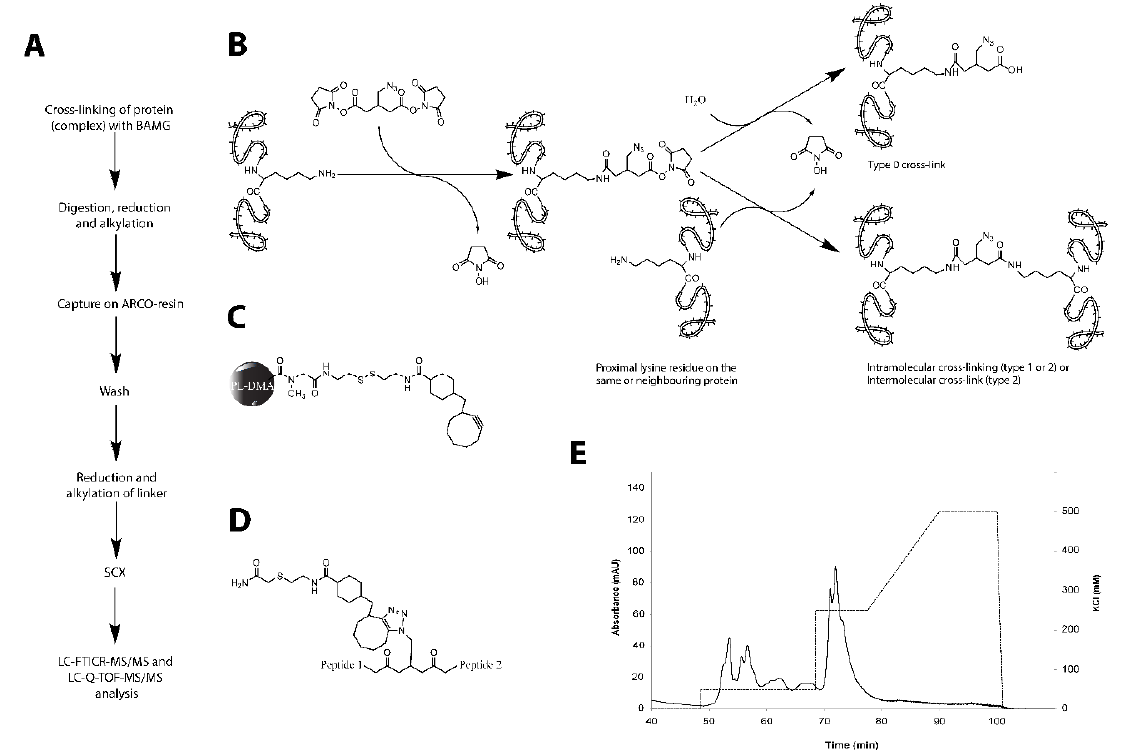
Figure 1. Overview of the used cross-linking methodology and terminology. ( A ) experimental work flow. Proteins are incubated with the azide-containing cross-linker bis (succinimidyl)-3-azidomethyl glutarate (BAMG). After cross-linking, proteins are digested and the obtained peptide mixture is incubated with the azide-reactive cyclooctyne (ARCO) resin to capture the cross-linked peptides out of the bulk of unmodified peptides. After cleavage from the resin, enriched peptides are fractionated by strong cation exchange (SCX) chromatography and analyzed by mass spectrometry. ( B ) structure of BAMG and its reactions with lysine residues in proteins. BAMG can react with a single lysine residue, the other reactive half of the cross-linker becoming either hydrolyzed or reacted with the quenching agent used to stop further cross-linking (type 0 cross-link), or it can react with two proximal lysine residues (type 1 or type 2 cross-linking). A type 1 cross-link occurs between two lysine residues in the same peptide after proteolytic digestion, while a type 2 cross-link connects lysine residues in different peptides. A type 2 cross-link can be formed in the same protein (intramolecular cross-linking) or between two different neighboring proteins (intermolecular cross-linking). BAMG adds 169.1 Da to a type 0 cross-linked peptide and 151.0 Da to type 1 and type 2 cross-linked peptides. ( C ) ARCO-resin, consisting of a poly-dimethylacrylamide solid support, a disulphide as a cleavable linker, and a cyclooctyne as a reactive group towards azides. Via the strain-promoted azide–alkyne cycloaddition, azide-containing peptides are captured on the resin. ( D ) enriched type 2 cross-linked peptides. The modification adds 509.2 Da to type 1 and type 2 cross-links and 527.2 Da to type 0 cross-links. ( E ) SCX chromatogram of enriched peptides. Type 0 and type 1 cross-linked peptides (solid line) elute predominantly at 50 mM KCl (dashed line), while elution of most type 2 cross-links occurs at a higher KCl concentration.